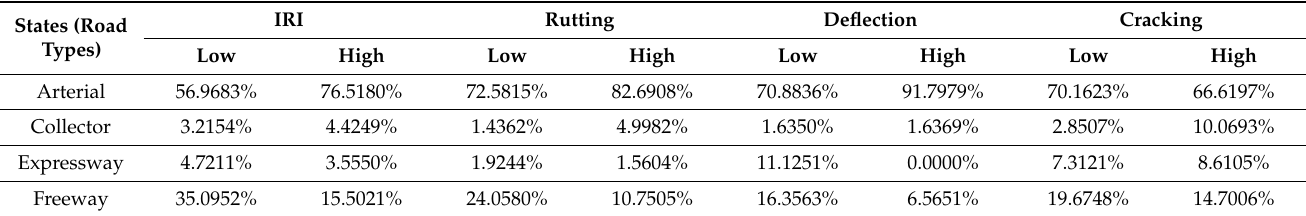
Table 9. Sensitivity analysis.